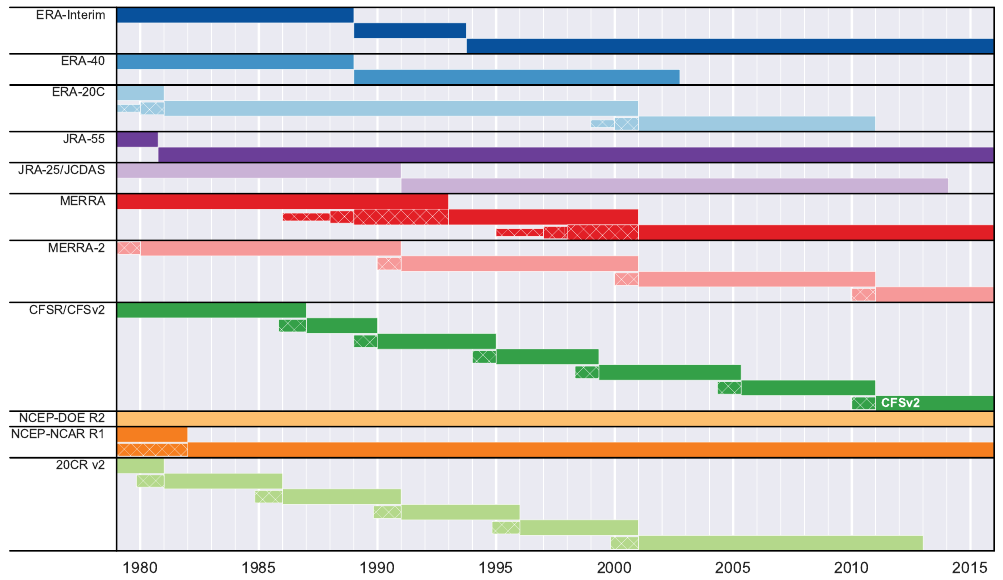
Figure 2. Summary of the execution streams of the reanalysis systems from January 1979 through December 2015. The narrowest cross- hatched sections indicate known spin-up periods, while the wider cross-hatched sections indicate overlap periods.